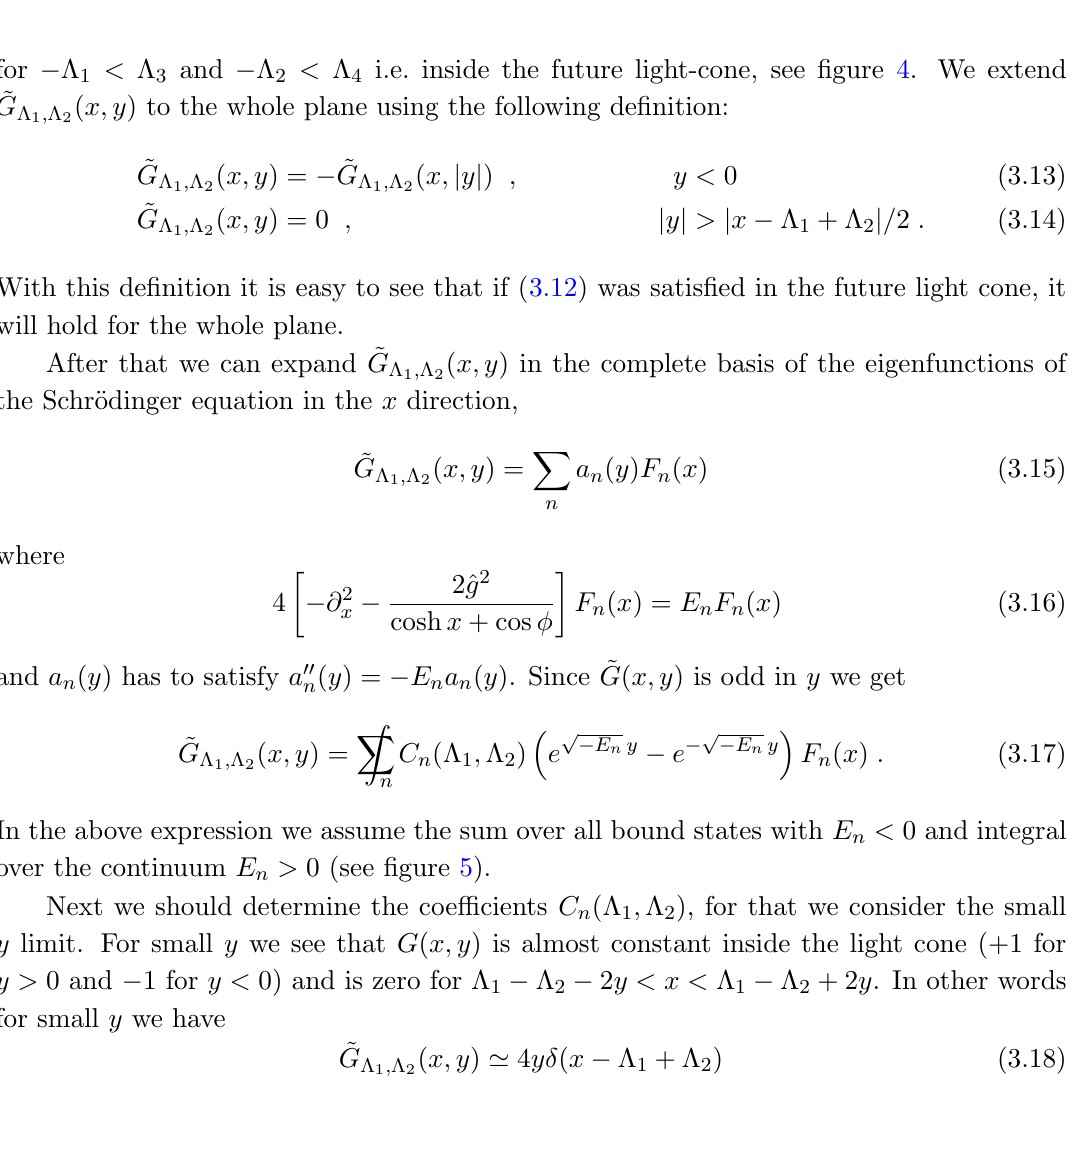
( x; y ) is 1 ; (cid:3) 2